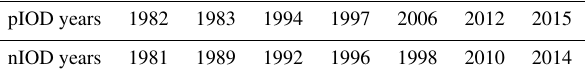
Table 1. List of positive IOD events and negative IOD events in our study